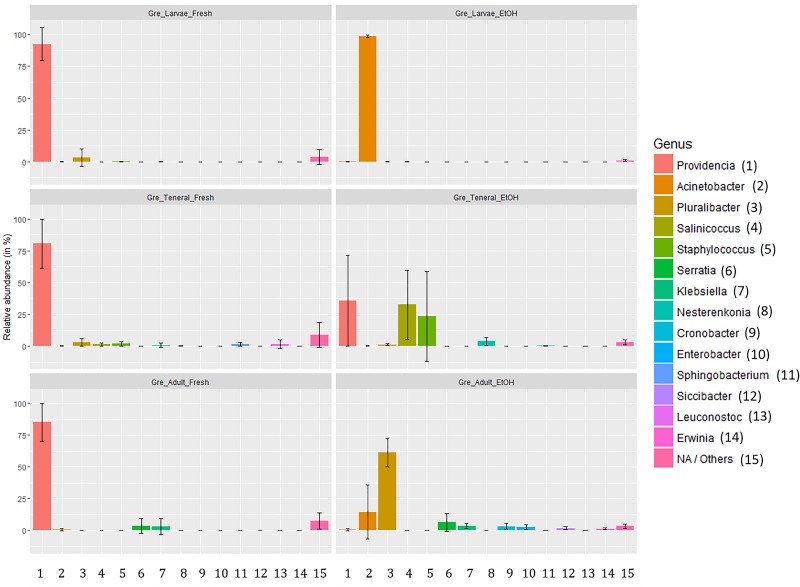
Relative abundance of gut symbionts (genus level classification) in fresh and ethanol preserved specimens of larvae, teneral, and adults of C. capitata from the colony strain of Greek origin.